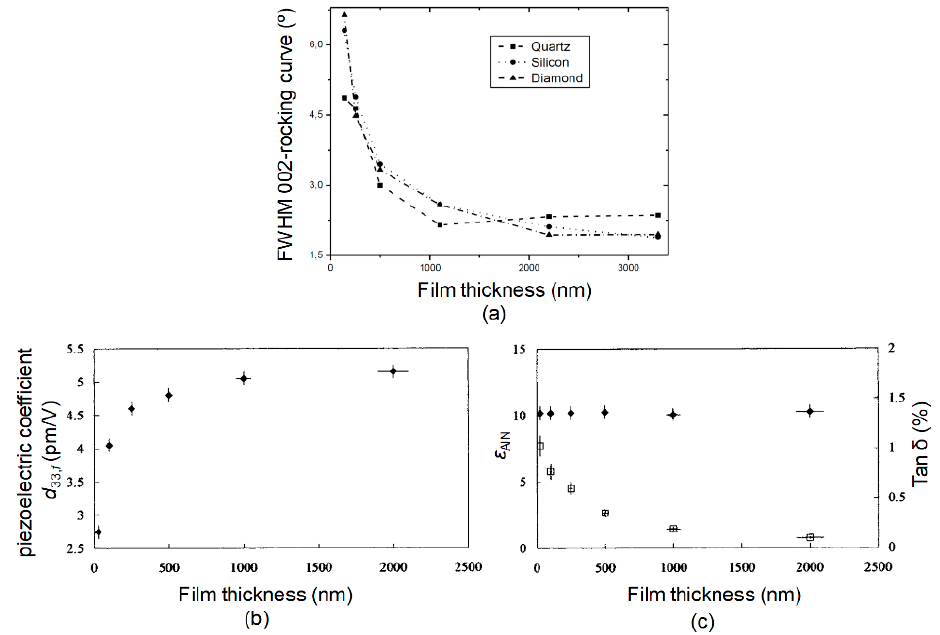
Figure 7. E ff ects of di ff erent thicknesses of AlN. ( a ) Rocking curve full-width half-maximum (FWHM) on di ff erent substrates, reproduced with permission from [35]. ( b ) Piezoelectric coe ffi cient d 33 , reproduced with permission from [29]. ( c ) Permittivity ( ε AlN solid circles) and dielectric loss (Tan δ , open squares), reproduced with permission from [29].